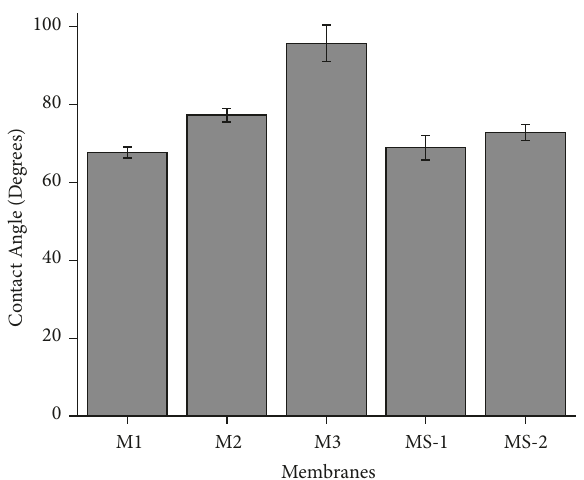
Figure 4: Contact angle of formulated membranes analysed by ImageJ. Error bars represent standard deviation and five measure- ments were recorded for contact angle.